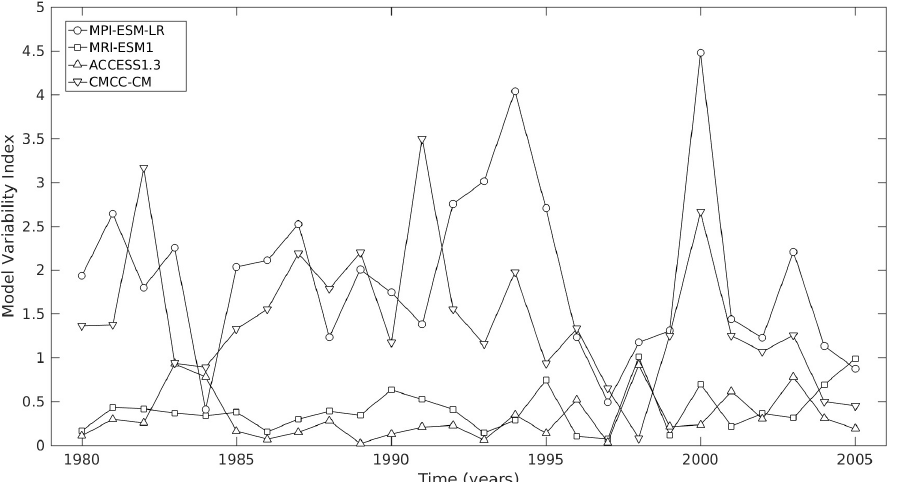
Figure 11. Model variability index as a function of time, computed taking into account all of the WPs and